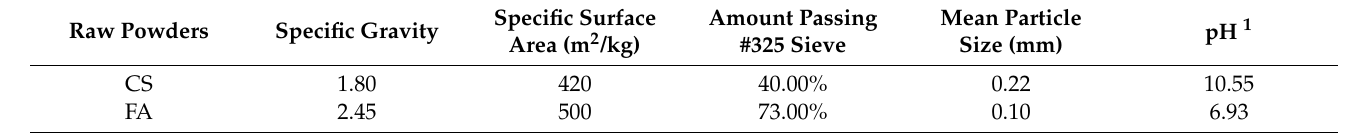
Table 2. Basic indexes of CS and